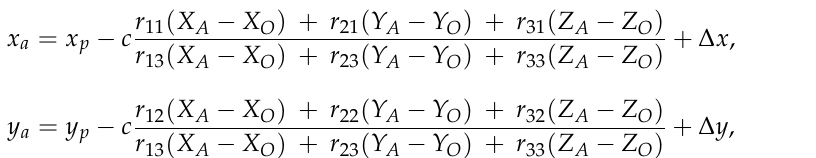
Table 1. Qaser Amra GCP-adjusted coordinates in UTM zone 37. Point Id